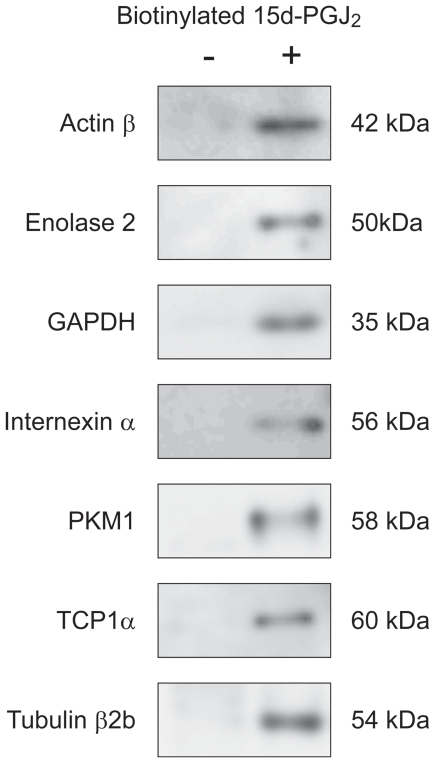
Interactions of 15d-PGJ2 with targets.Membrane proteins (400 µg) were incubated with 1 µM biotinylated 15d-PGJ2 at 4°C for 24 h. Membrane lysates were incubated with Streptavidin Agarose. The presence of targeted proteins was detected by immunoblot analysis, and the incorporation of biotinylated 15d-PGJ2 into immunoprecipitates was detected with ECL.